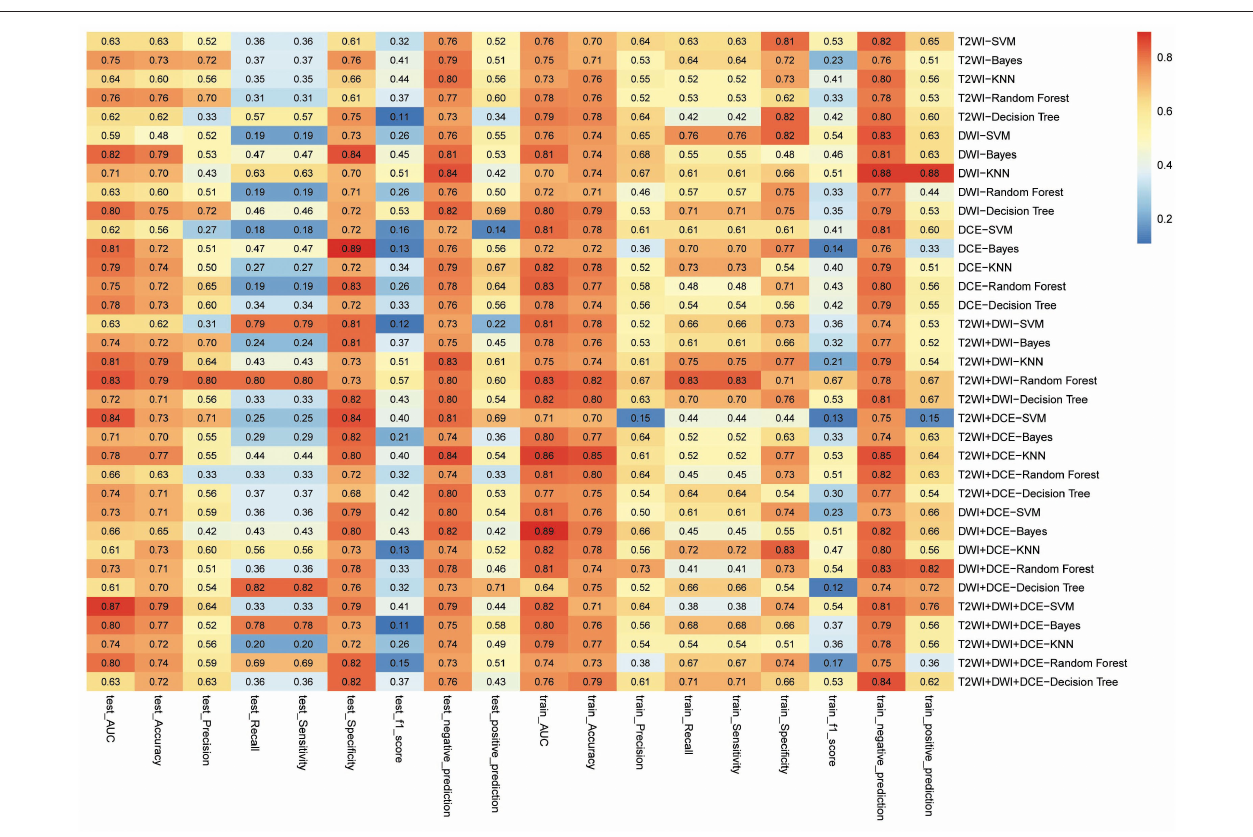
FIGURE 4 | The evaluation results of radiomics signature combined features from different imaging sequences and machine learning methods. The right column of the figure shows the combination of different sequences. The horizontal coordinate shows different items to be evaluated in the training set and the test set, and the value in each frame represents the evaluated result of the items of the corresponding sequence combination. The closer the color is to red, the greater the value. In this study, the larger the AUC value represents the better combined model built by machine